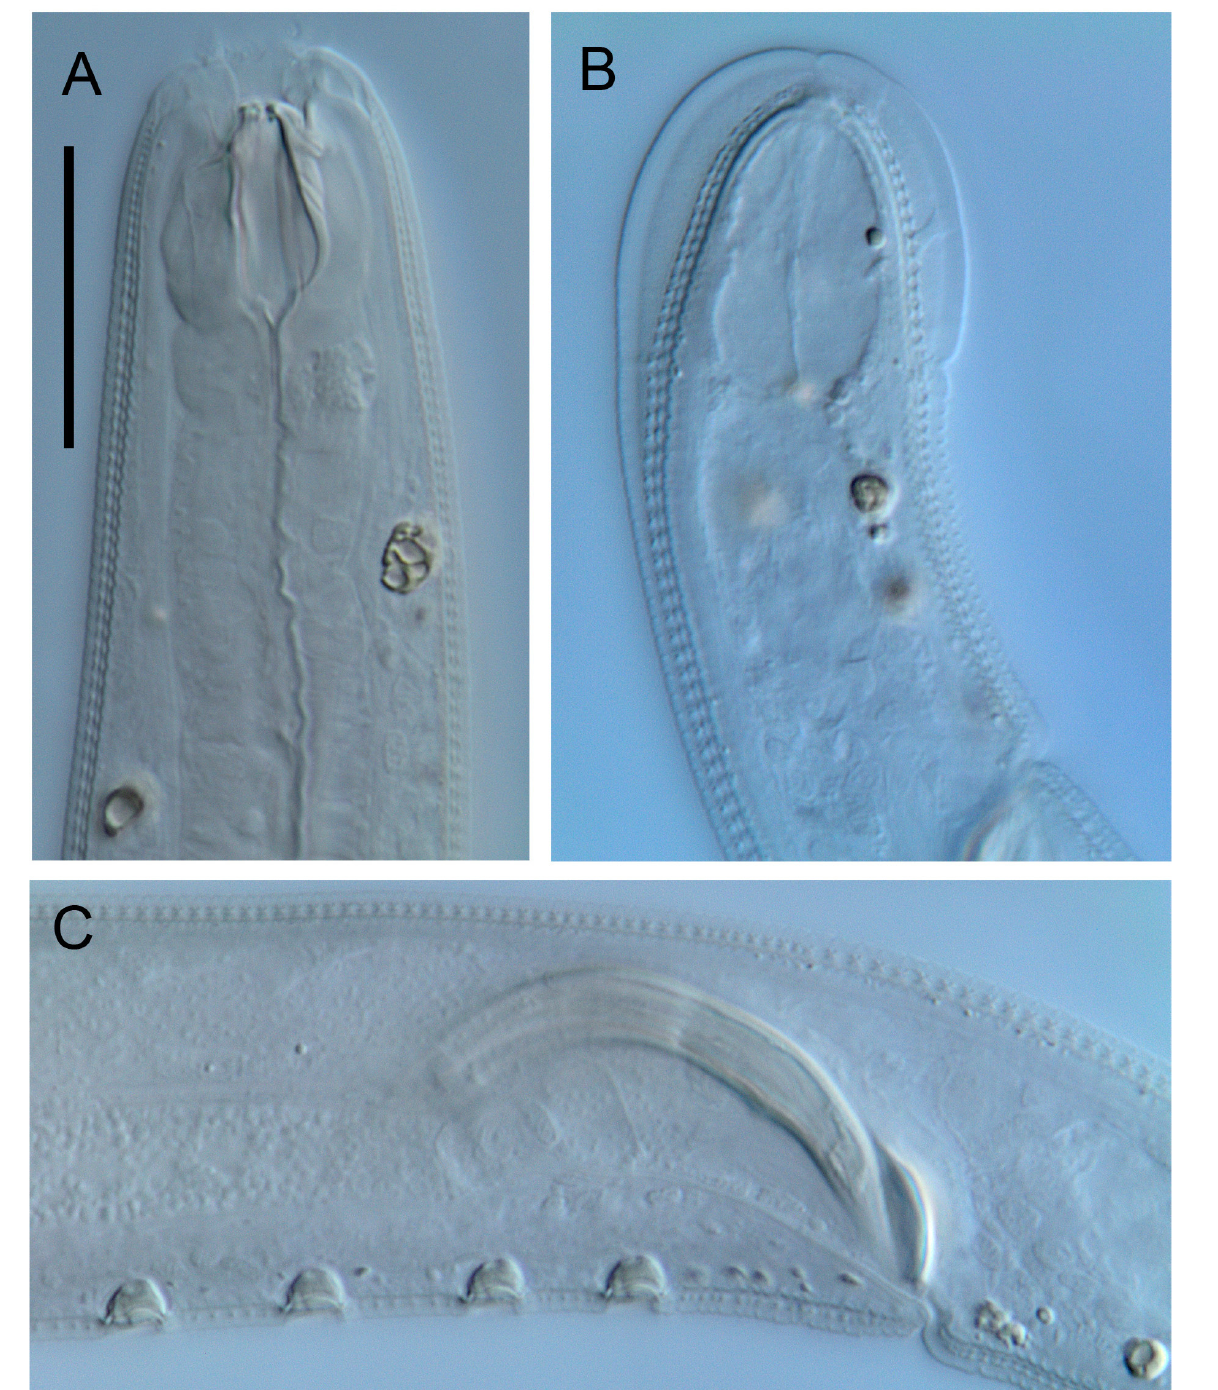
Fig. 3. Synonchiella rotundicauda sp. nov. Light micrographs. A . Anterior body region of male showing buccal cavity. B . Tail of male. C . Spicular apparatus. Scale bar = 25